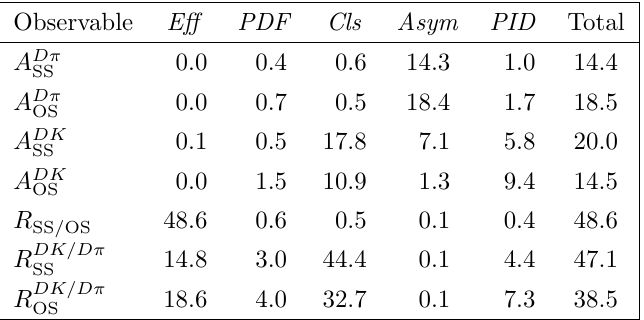
Table 3 . Systematic uncertainties for the non- K (cid:3) + region (cid:12)t. Uncertainties are quoted as a percentage of the statistical uncertainty for a given observable, and the total uncertainty is given by the sum in quadrature of each